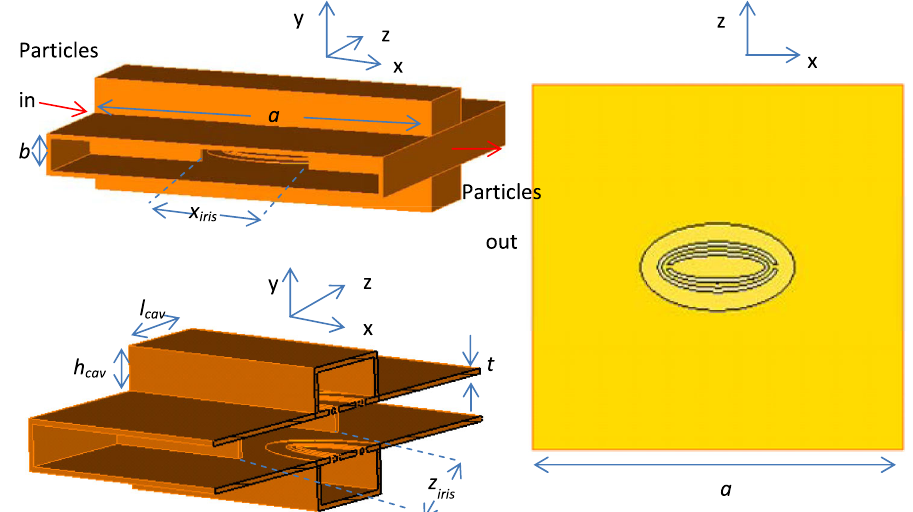
FIG. 2. Perspective (upper left), top view with outer rectangular cavity removed (right) and cut-plane view (bottom left) of the proposed deflecting structure.